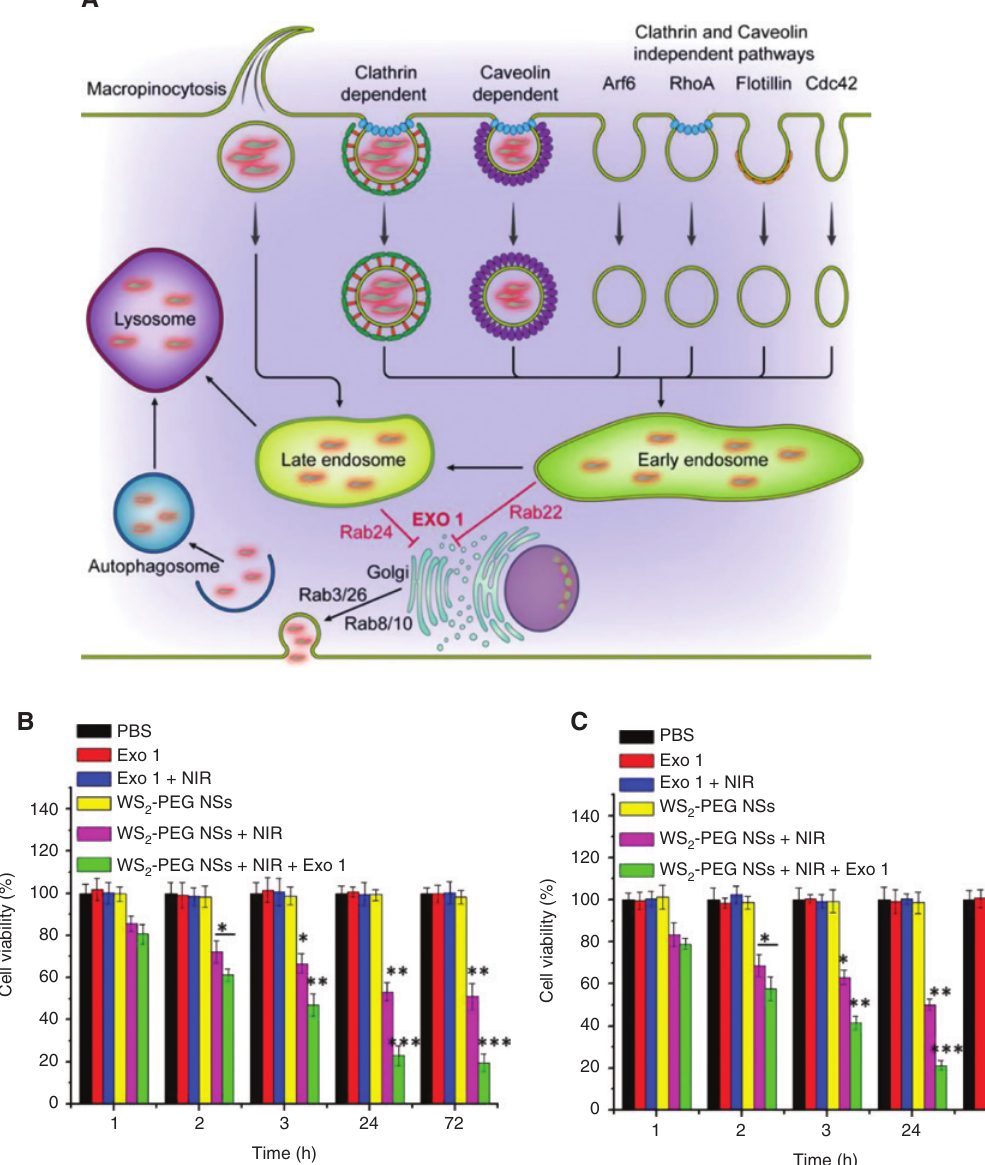
NSs. Cell viability of (B) HeLa cells or (C) MCF-7 cells after the following treatments at Figure 8: (A) Summary of the intracellular fate of WS 2 different time points: (1) PBS, (2) Exo1, (3) Exo1 + NIR, (4) WS -PEG NSs, (5) WS -PEG NSs + NIR, (6) WS -PEG NSs + Exo1 + NIR. 2 2 2 The concentration of WS was 100 μ g ml −1 , while that of Exo1 was 50 μ g ml −1 . NIR irradiation was conducted at the power density of 0.5 W 2 cm −2 (5 min). MTT assay was used to determine the cell